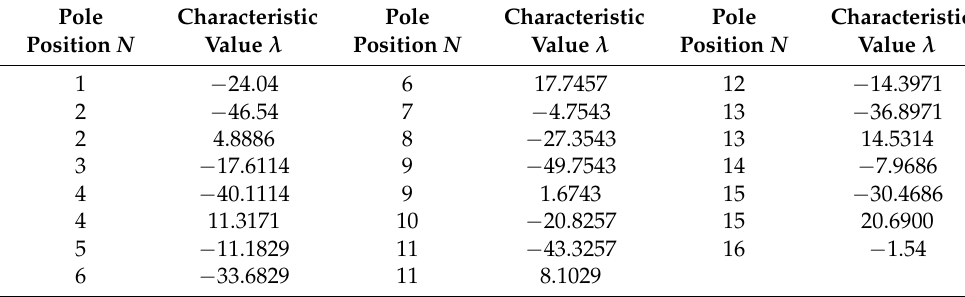
Table 1. Characteristic values and corresponding outer alnico pole positions.